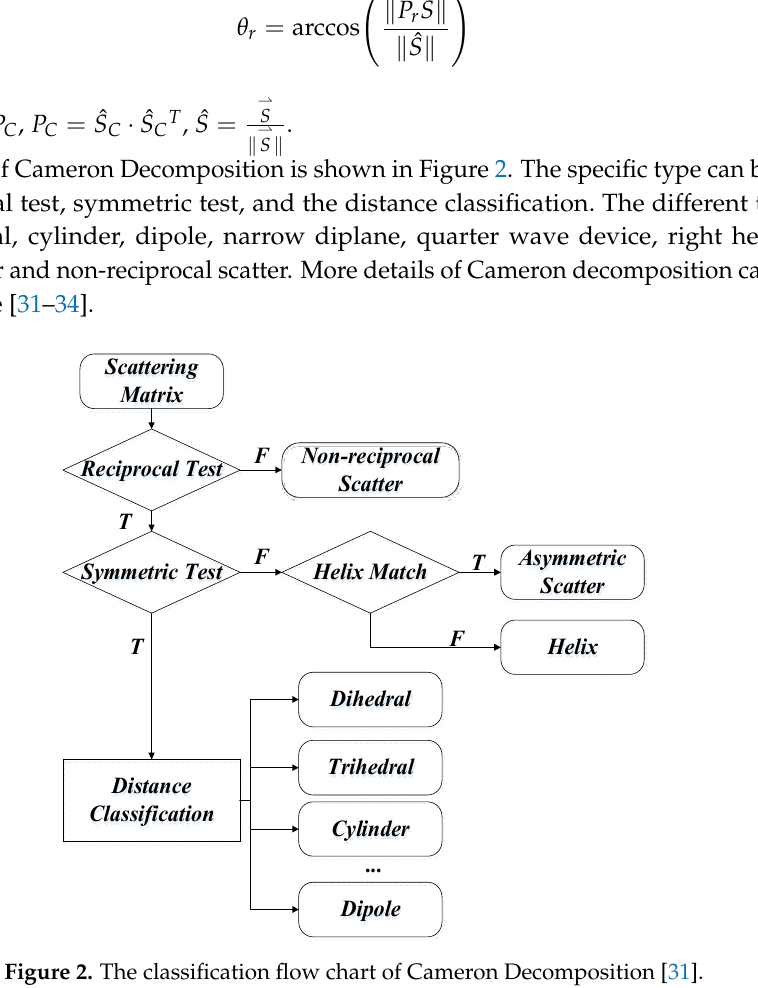
Figure 2. The classification flow chart of Cameron Decomposition [31].